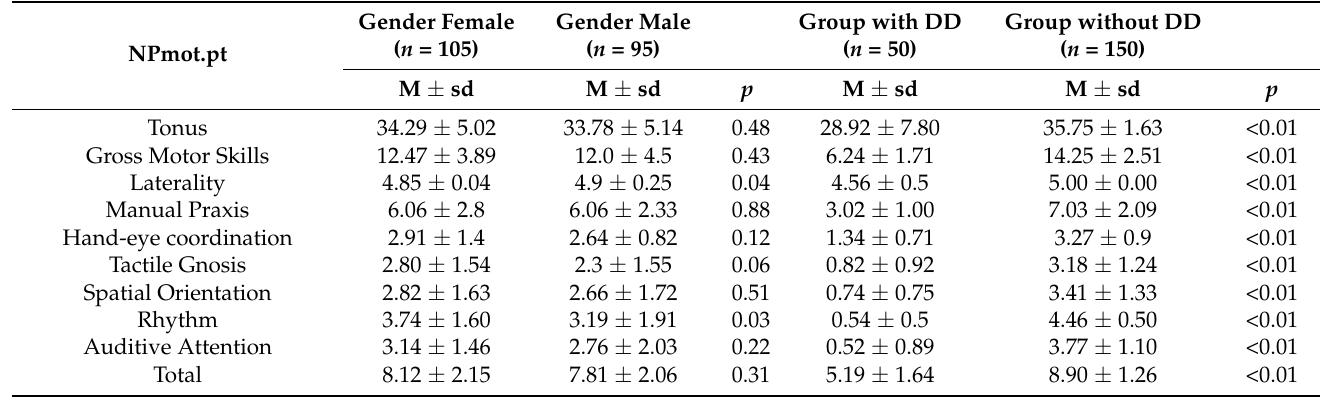
Table 7. Means, standard deviation and Student’s t-test of NPmot.pt domains by gender and diagnosis ( n =